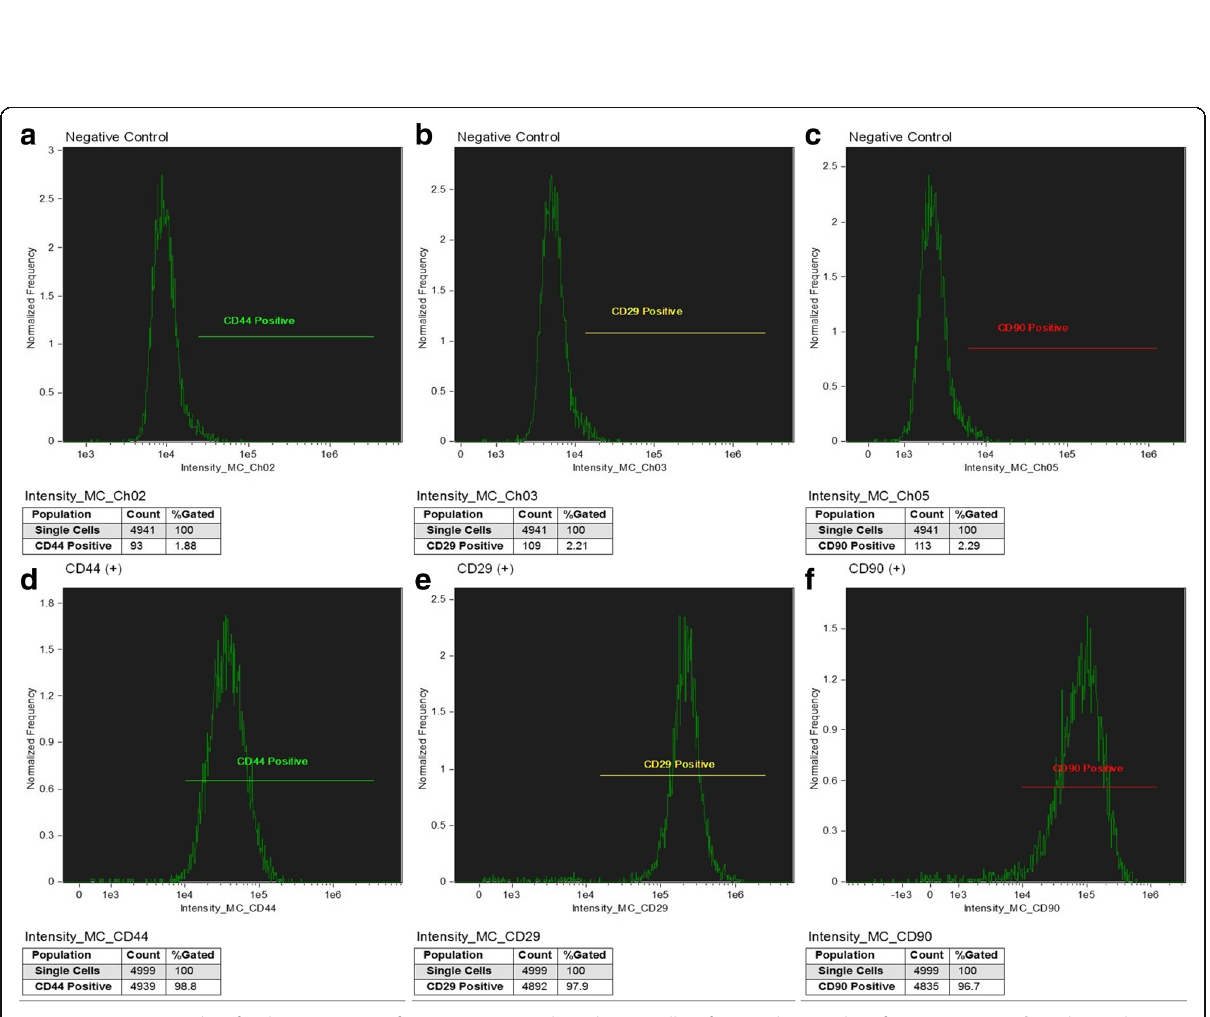
Fig. 3 Representative data for the expression of osteocyte mesenchymal stem cell surface markers markers from negative ( a , b and c ) and positive ( d , e and f ) controls using immunoglobulin and specific antibody for CD44, CD29 and CD90. The number of cells analyzed was 1,000,000 for each of the labeled cell types. Purchased from AMNIS employing DiVa software 4.0 and analyzed with Flowjo / Mac version